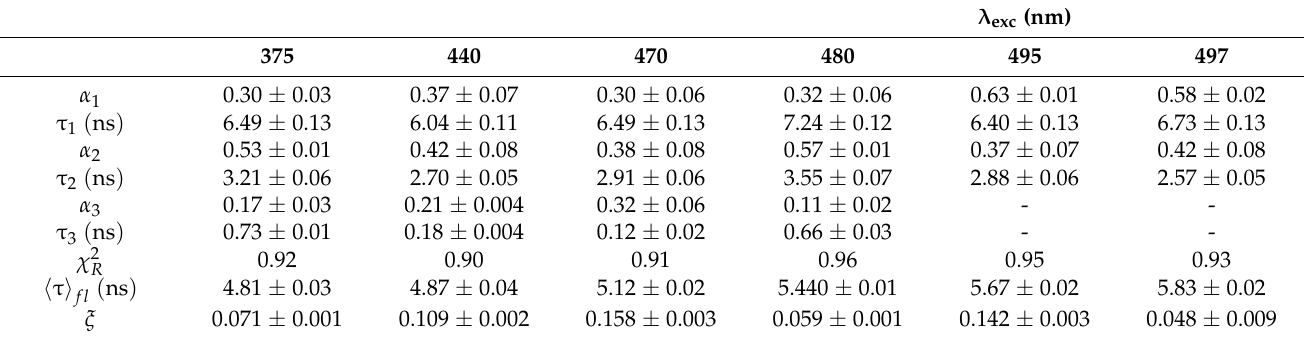
Table 5. The parameters of FMN fluorescence decay in PVA film (rigid solutions) fitted to the sum of three and two ( ns ) , obtained from Equation (9), at different λ exc exponentials, and the values of mean FMN fluorescence lifetime (cid:104) τ (cid:105) fl from 370 nm to 497 nm and λ obs = 530 nm, at T = 293 K for sample 7 × 10 − 5 M. The parameters were estimated from the best fit with the data with calculated standard deviations.